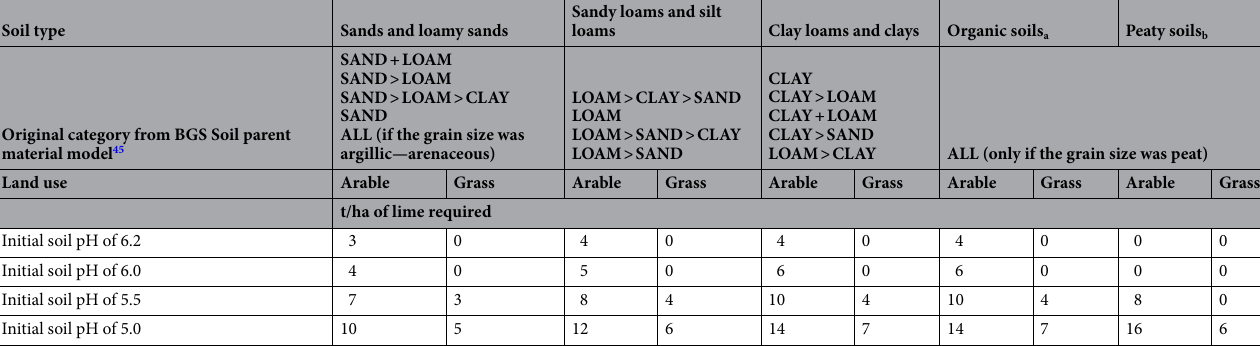
Table 1. Liming requirements look-up table, adapted from Agriculture and Horticulture Development Board 12 . a For mineral and organic soils, the target soil pH is 6.7 for continuous arable cropping and 6.2 for grass. Aim for 0.2 units above the optimum pH. b For peaty soils, the target soil pH is 6.0 for continuous arable cropping and 5.5 for grass. Aim for 0.2 units above the optimum pH.